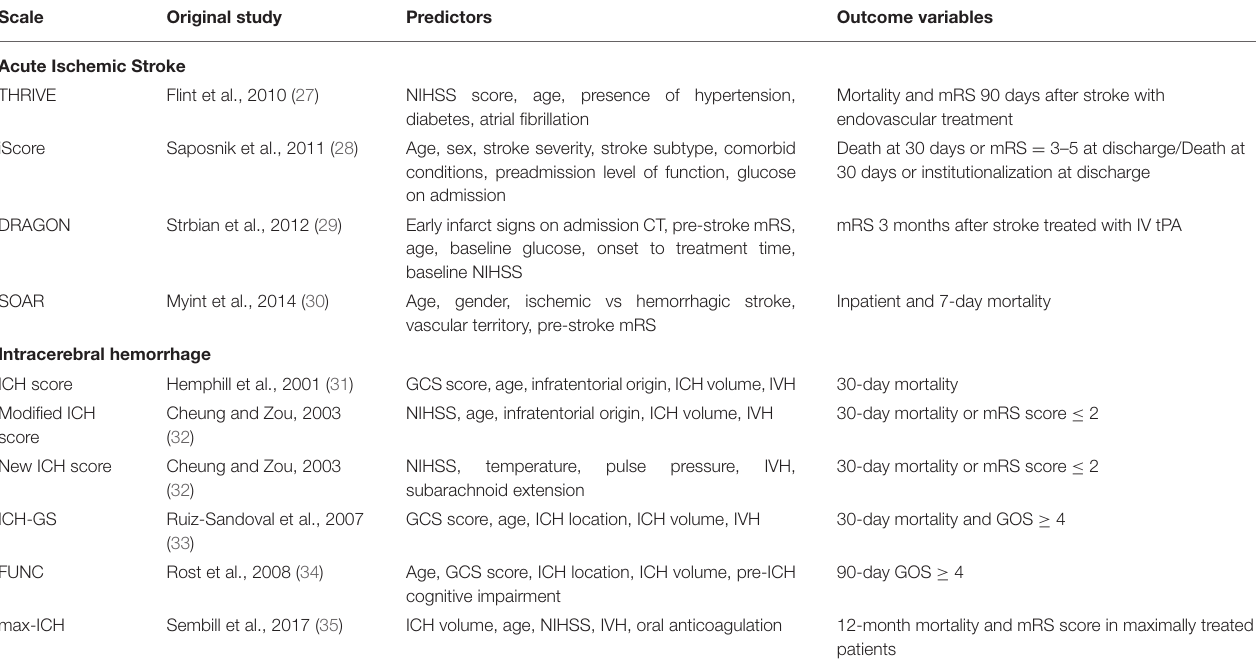
TABLE 1 | Selected clinical scales developed for acute ischemic stroke and intracerebral hemorrhage.